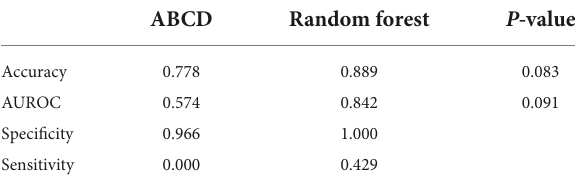
TABLE 4 ABCD versus random forest